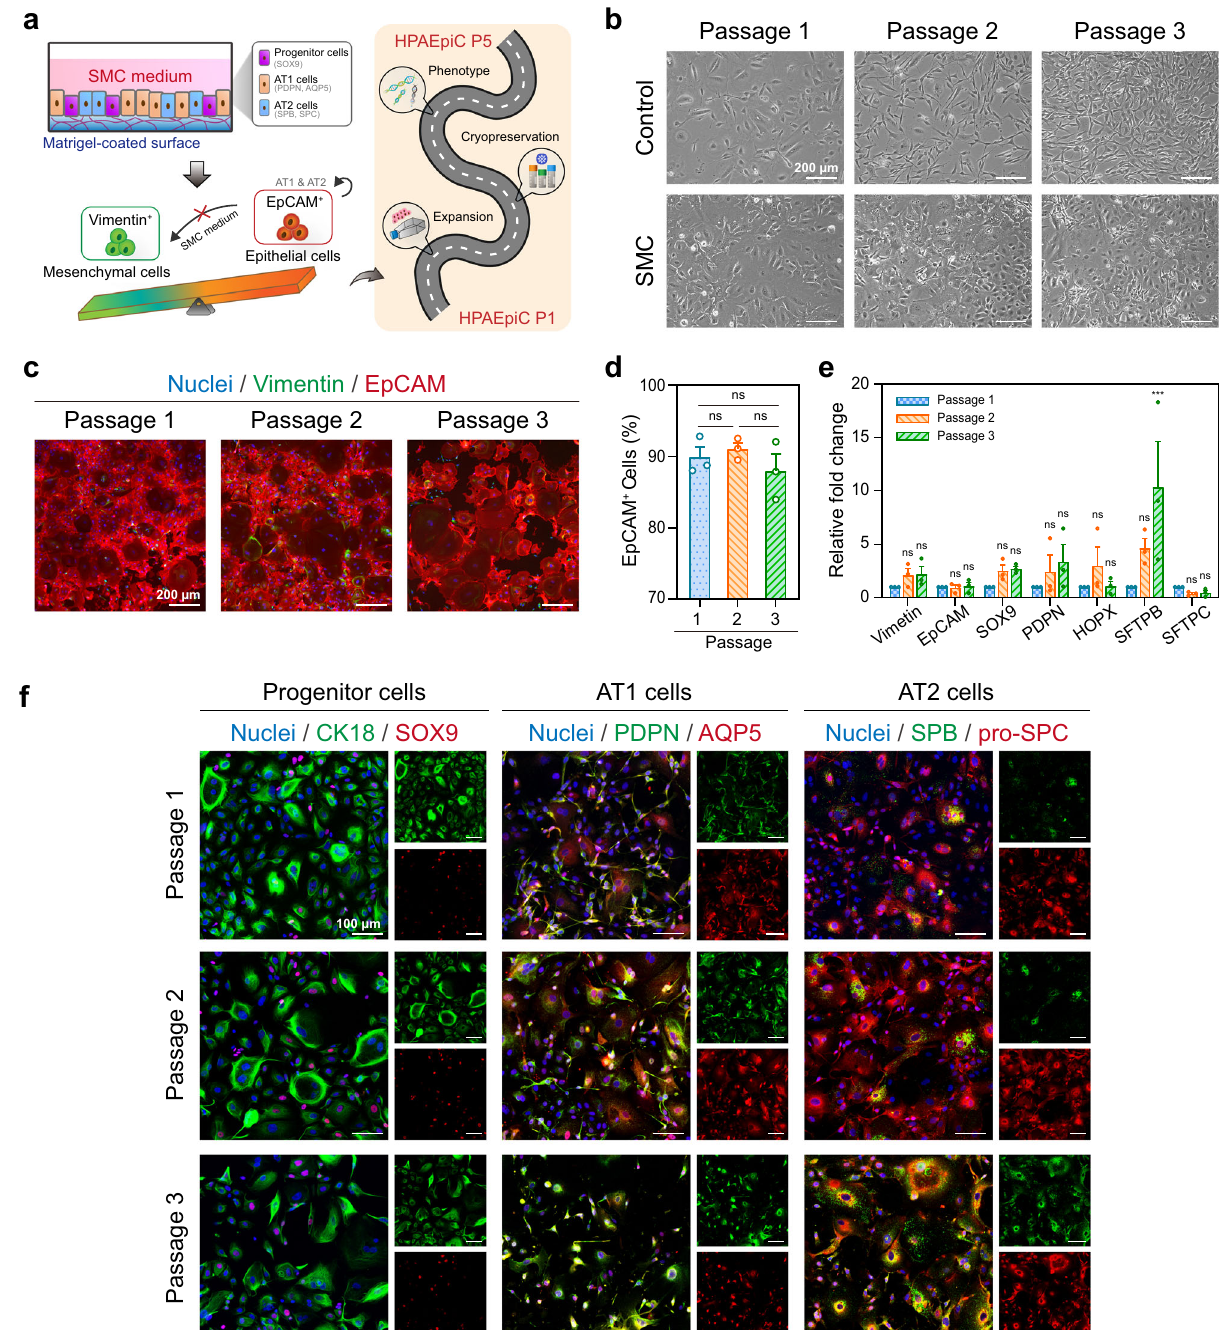
Fig. 2 SMC medium support of HPAEpiC growth and expansion in serial passages. a Schematic of experiment showing the SMC medium support of long-term HPAEpiC passage culture. Experiments were devised to determine whether the HPAEpiC phenotype was maintained after expansion and cryopreservation. b Bright- fi eld microscope images showing changes in HPAEpiC morphology after the serial passage. In the control medium, the Passage- 2 cells were almost elongated spindle-shaped (mesenchymal-like cells), whereas the SMC medium maintained a cobblestone epithelial morphology from passages 1 to 3. c When serial passaging was performed in the SMC medium, the HPAEpiCs were stained with Vimentin (green) and EpCAM (red) antibodies. d Quanti fi cation of EpCAM + cell populations. Data showed that the SMC medium supports maintenance of the HPAEpiC epithelial cell phenotype between Passages 1 and 3. e mRNA expression of Vimentin (mesenchymal cells), EpCAM (epithelial cells), SOX9 (alveolar progenitor cells), PDPN and HOPX (AT1 cells), as well as SFTPB and SFTPC (AT2 cells). f Immunostaining of CK18 and SOX9 (alveolar progenitor cells), PDPN and AQP5 (AT1 cells), as well as SPB and pro-SPC (AT2 cells). From d – f , the SMC medium supports the maintenance of the alveolar progenitor, AT1, and AT2 cell phenotypes of the HPAEpiCs between Passages 1 and 3. Data and error bars represent mean ± SEM from three separate experiments. One-way ANOVA test ( d , e ). *** p < 0.001; ns non-signi fi